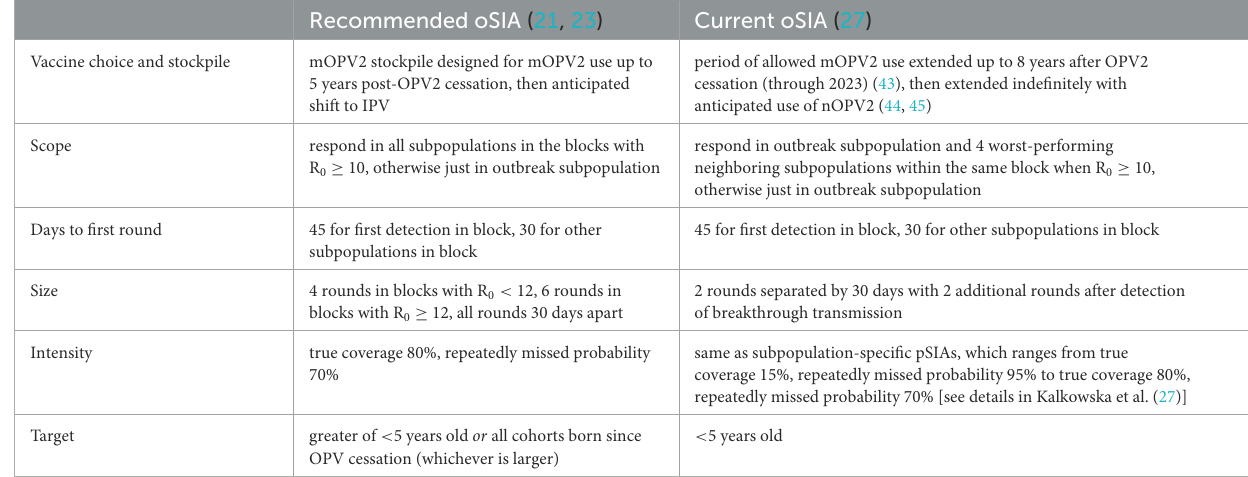
TABLE 1 Characteristics of outbreak response supplemental immunization activities (oSIAs) recommended prior to OPV2 cessation (21, 23) and currently in use after OPV2 cessation (27).